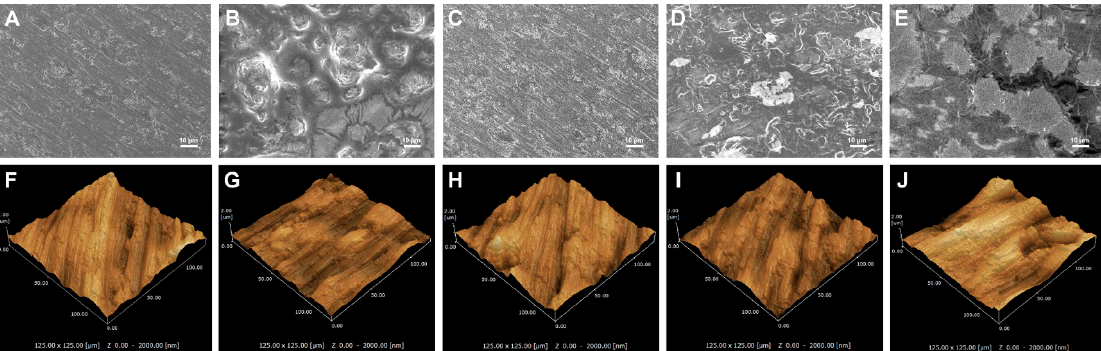
Figure 2. Gross appearance of titanium (Ti) ( A ), Tallow-Ti ( B ), Finevo-Ti ( C ), Plasma-Ti ( D ), and UV-Ti ( E ). Dirt on the surface of the sample dipped in tallow was removed by using Finevo.